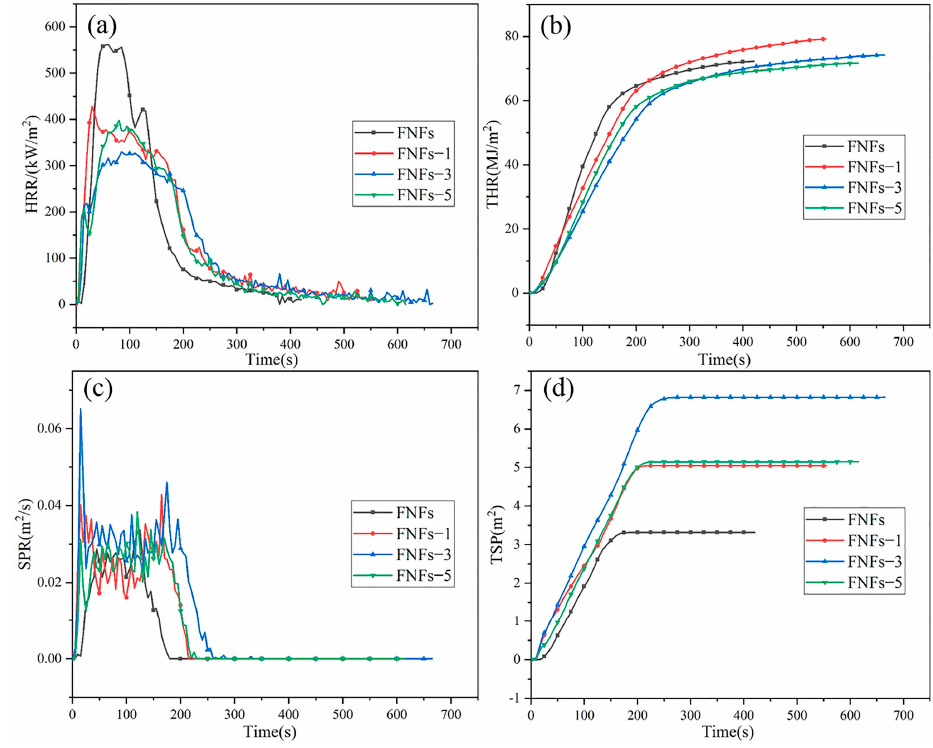
Figure 6. Curves of HRR ( a ), THR ( b ), SPR ( c ), and TSP ( d ). The smoke produced in a fire is one of the most important factors and directly leads to death due to asphyxia and/or inhalation of toxic gases [32]. Figure 6c,d and Table 2 clearly show the smoke emission behavior of the FNFs, FNFs-1, FNFs-3, and FNFs-5 after combustion. As seen in Table 2, the Av-COY and Av-CO 2 Y of the FNFs samples after combustion were 0.275 kg/kg and 7.9 kg/kg, respectively. Compared with the FNF sample, the Av-COY and Av-CO 2 Y of the coated FNFs decreased significantly; the FNFs-5 sample had the lowest Av-COY and Av-CO 2 Y, reducing to 0.013 kg/kg and 0.9 kg/kg. As shown in Figure 6c, the first peak of the coated sample appeared in the SPR curve soon after combustion, which was related to the decomposition of the phosphate ester group in the coating [34]. The decomposition of the phosphate ester group increased the formation of the carbon layer, which effectively reduced the Av-COY and AV-CO 2 Y. However, the TSP value of the coated FNFs increased significantly, from 3.3 m 2 to 6.8 m 2 , which was attributed to the large amount of small particles produced by the coating after combustion. Therefore, the cone calorimetry results showed that the FNFs-5 sample had a better comprehensive flame